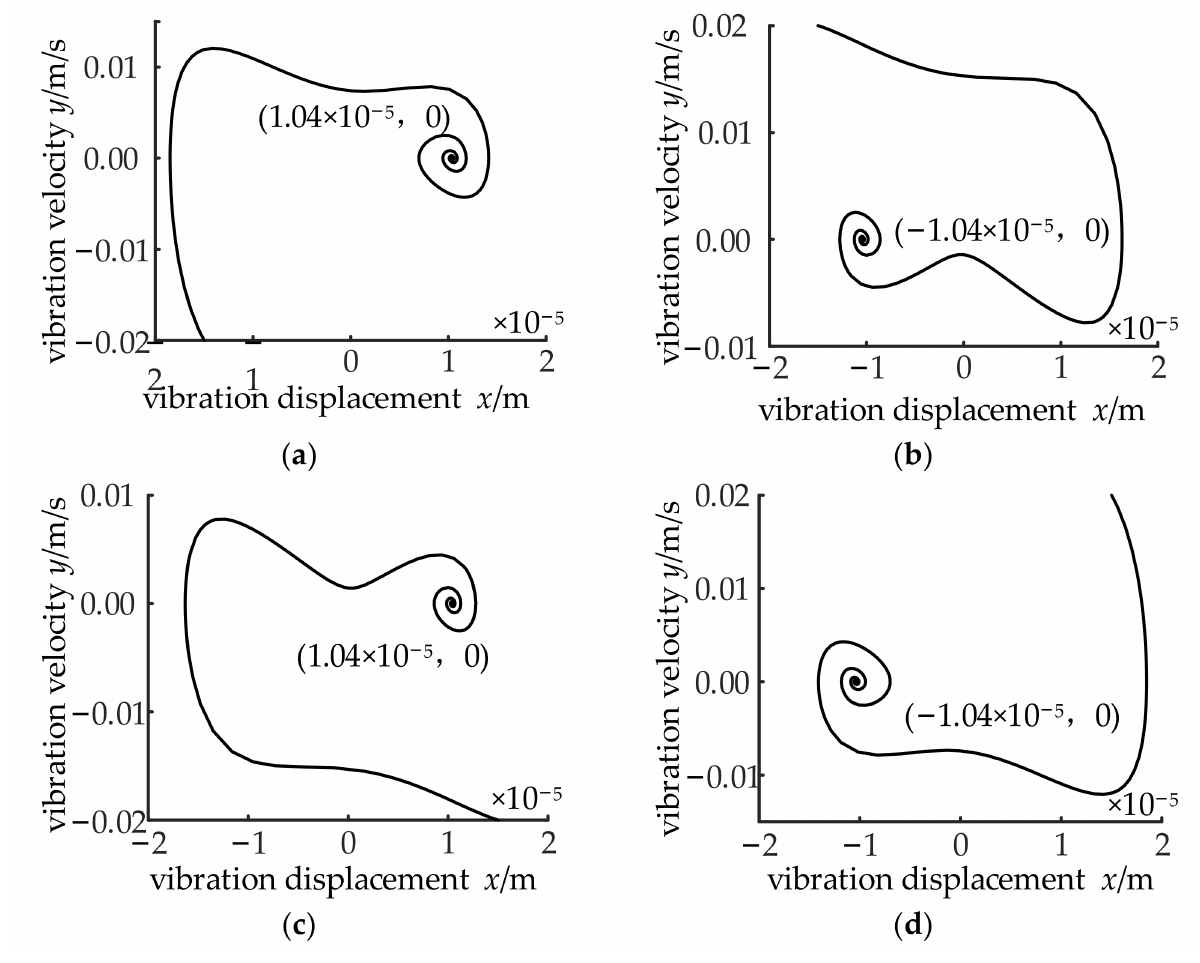
Figure 8. Phase trajectories when K p = − 30. ( a ) ( − 1.5 × 10 − 5 , − 0.02). ( b ) ( − 1.5 × 10 − 5 , 0.02). ( c ) (1.5 × 10 − 5 , − 0.02). ( d ) (1.5 × 10 − 5 ,